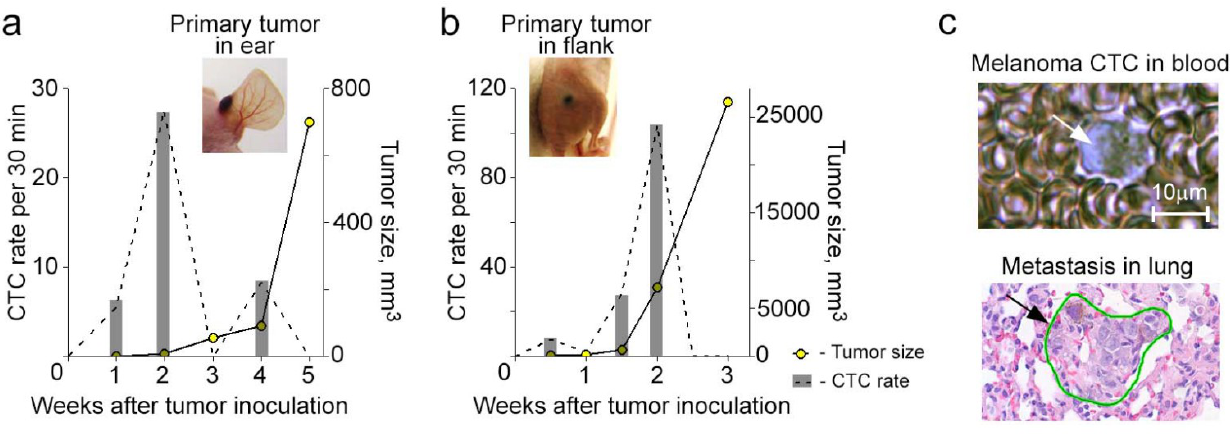
Figure 5. Dynamic interrelationship of CTC count and primary tumor size in the progression of metastatic melanoma. ( a , b ) CTC dynamic with the maximum number before the primary tumor starts progressively growing in the mice with a primary tumor in ear ( a ) and flank ( b ); ( c ) Images of a melanoma CTC in a fresh blood sample ex vivo (top) and a lung metastasis in a histological section in vitro (bottom) obtained at week 4 post tumor inoculation. White arrow (top image) show the pigmented CTC; black arrow and green line (bottom image) indicate metastasis.